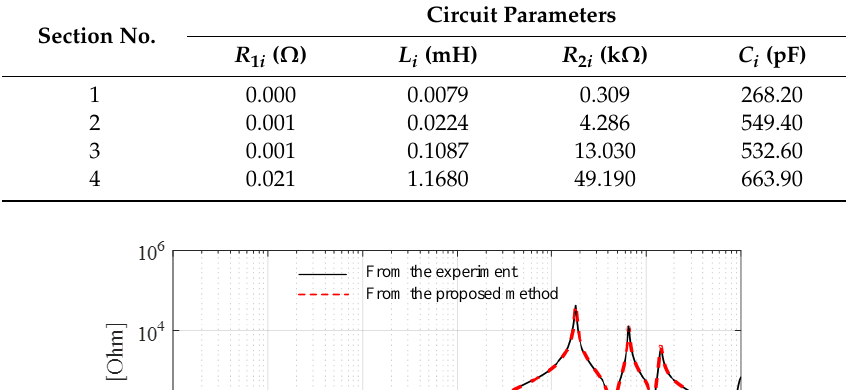
Table 2. Circuit parameters determined by the proposed approach.